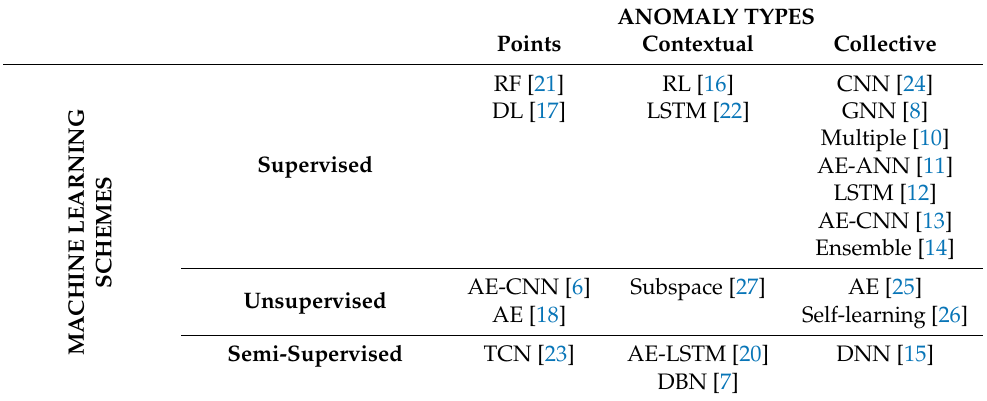
Table 2. Learning Algorithms According to Anomaly Types and Machine Learning